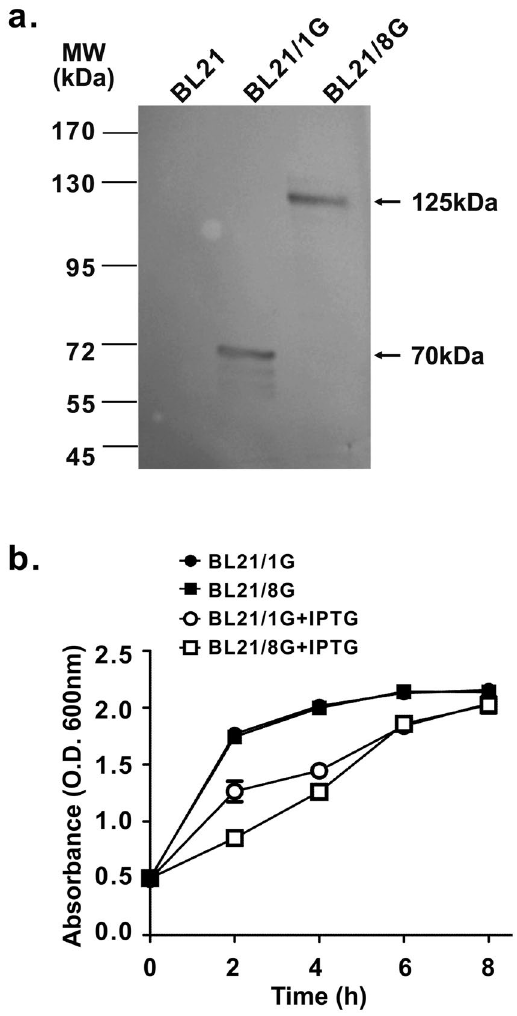
Figure 2. Expression of poly-protein G in BL21 bacteria. ( a ) The expression of poly-protein G in BL21 bacteria was analyzed by Western blot using a mouse anti-HA tag antibody. Lane 1, BL21 as negative control; Lane 2, single protein C2 domain-expressing BL21 bacteria (BL21/1G); Lane 3, eight tandemly repeated C2 domain- expressing BL21 bacteria (BL21/8G). ( b ) The transformed BL21 bacteria were induced by IPTG, and the growth rate of the bacteria was measured by recording the absorbance at 600 nm every two hours. ( ● )BL21/1G, ( ■ ) BL21/8G, ( ○ )BL21/1G + IPTG, ( □ )BL21/8G + IPTG. Bar,